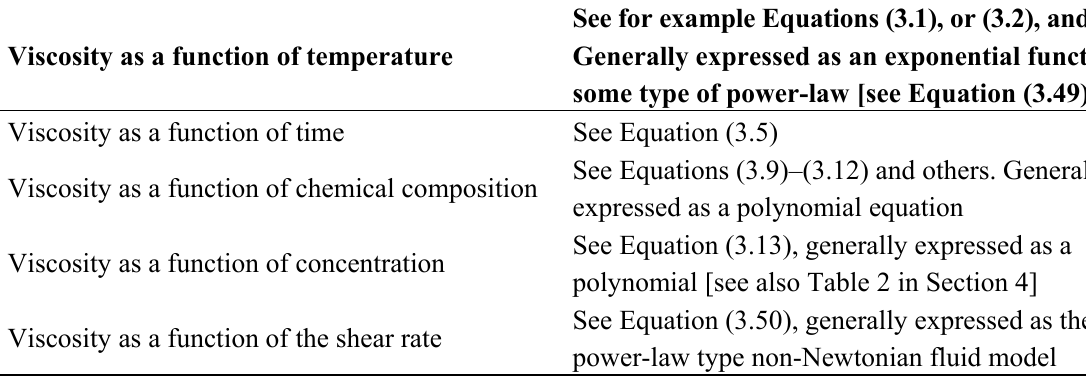
Table 1. Examples of viscosity of the slag as a function of temperature, time, chemical composition, concentration, and shear